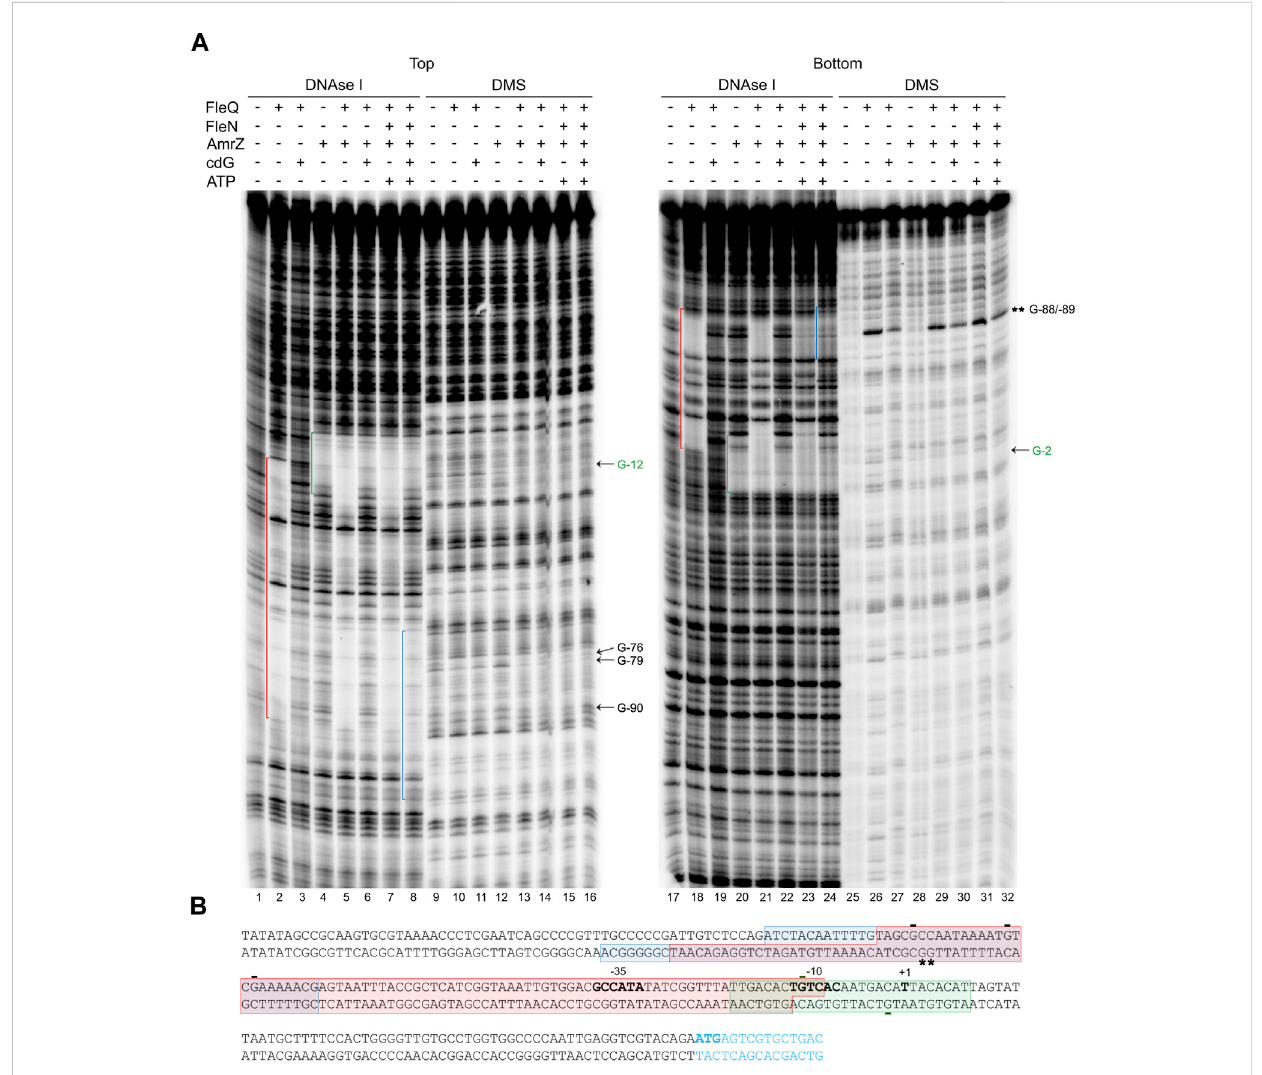
FIGURE 6 Location of all the regulators binding sites at the wss promoter. (A) DNAse I and DMS footprint. DNA probes corresponding to the wssA upstream region5 ’ end-labeledoneitherthetoporthebottomstrandwerepreparedandincubatedwithout(lanes-)andwith(+)FleQand/orFleN,AmrZ,ATPand c-di-GMP. After partial digestion with DNase I or treatment with DMS and partial digestion with piperidine, the DNAs were subjected to urea-PAGE. Nucleotide sequences protected by FleQ and FleQ-FleN in the absence of c-di-GMP (red), by the FleQ-FleN complex in the presence of c-di-GMP (blue)orbyAmrZbothintheabsence andinthepresenceofc-di-GMP(green)areindicated.Protected(arrow)andhyperreactive (*)nucleotidesarealso indicated. (B) SimultaneousbindingofFleQ,FleQ-FleNandAmrZ atthewsspromoter.TheboxesindicatetheregionsprotectedfromDNAseIbyFleQor FleQ-FleNintheabsenceofc-di-GMP(red),FleQ-FleNinthepresenceofc-di-GMP(blue)orAmrZbothintheabsenceandinthepresenceofc-di-GMP (green) in the top and bottom strands. The -10 and -35 regions and the wss transcriptional start site are in bold. *, indicates hyperreactivity and -,